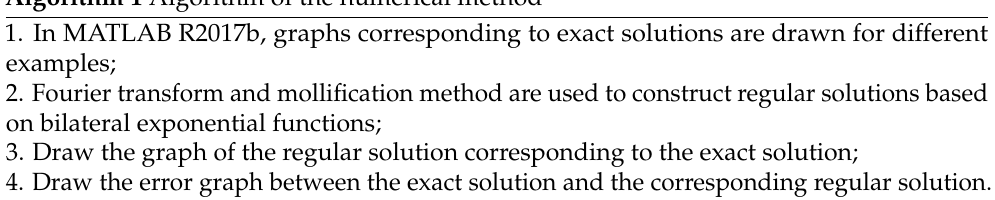
Algorithm 1 Algorithm of the numerical